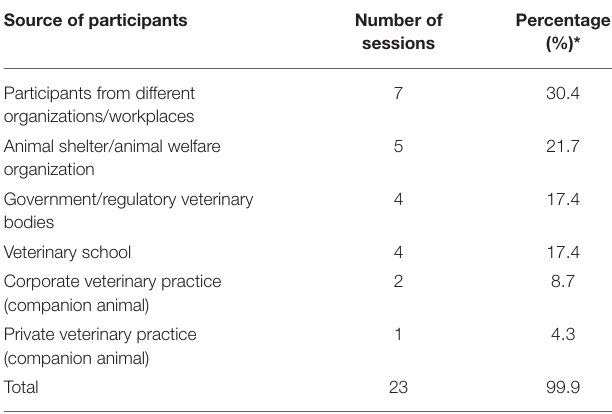
TABLE 2 | Frequency table describing the number of sources of participants in virtual ethics rounds sessions for veterinary team members ( n = 23